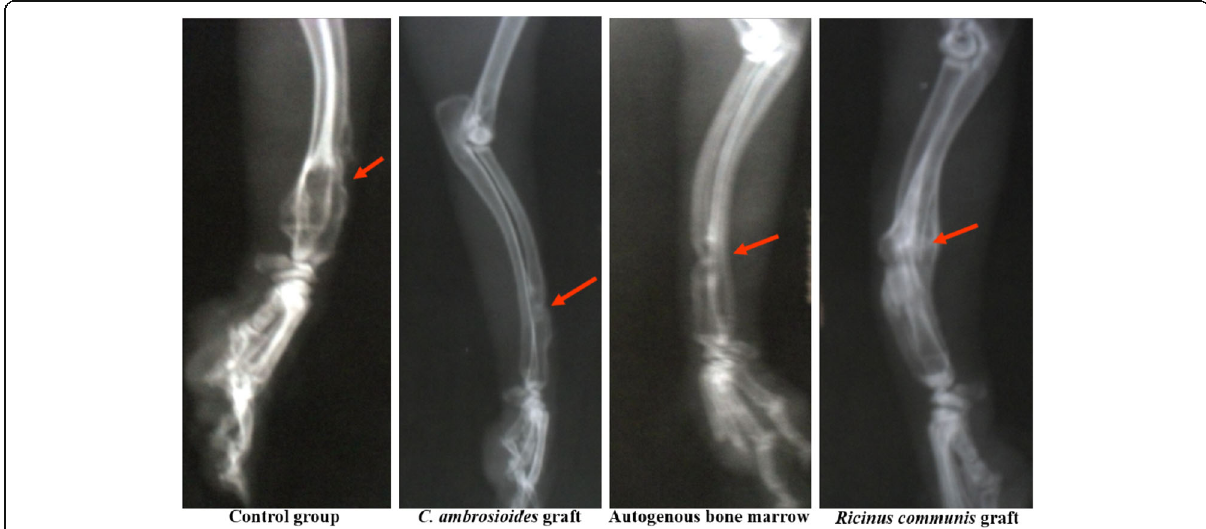
Fig. 3 Effect of a graft of lyophilized aqueous Chenopodium ambrosioides L. extract on bone formation. Radiographs showing bone callus evolution after 90 day. Groups: Control group, C. ambrosioides graft, Autogenous bone marrow and Ricinus communis graft. Control group: Formation of a prominent fibrous bone callus. C. ambrosioides graft: Formation of a mature bone callus throughout the fracture line. Autogenous bone marrow: Formation of a mature bone callus. R icinus communis graft: Formation of a prominent fibrous bone